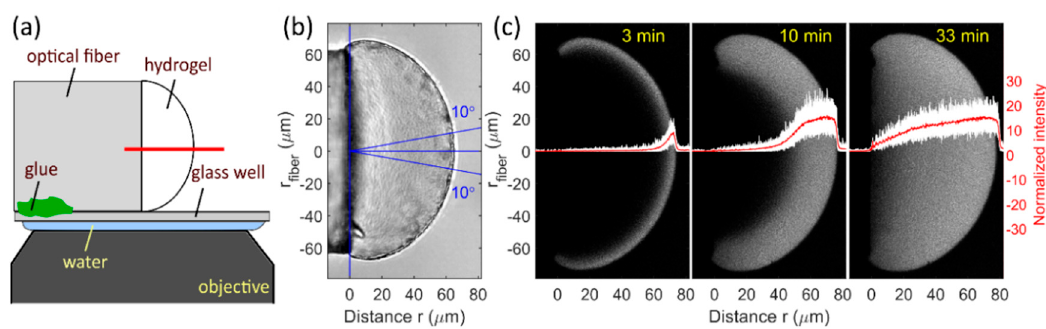
Figure 2. ( a ) schematic illustration of a hydrogel prepared covalently linked to the end face of the optical fiber. The fiber is glued to the bottom of a glass well dish for confocal laser scanning microscopy (CLSM) imaging. The red line indicates the position of the imaging plane ( b ) bright field optical micrograph of a selected MO hydrogel. The lines in blue depict the circular sector from which the fluorescence intensity profiles were extracted and averaged. ( c ) the hydrogel was immersed into a solution of fluorescently labelled target MO- T10 at time t = 0. The CLSM micrographs show the detected fluorescence at times t = 3, 10, and 33 min, depicting also in white the individual fluorescence profiles from the circular sector, and in red their average. The same procedure was used for DNA hydrogels.